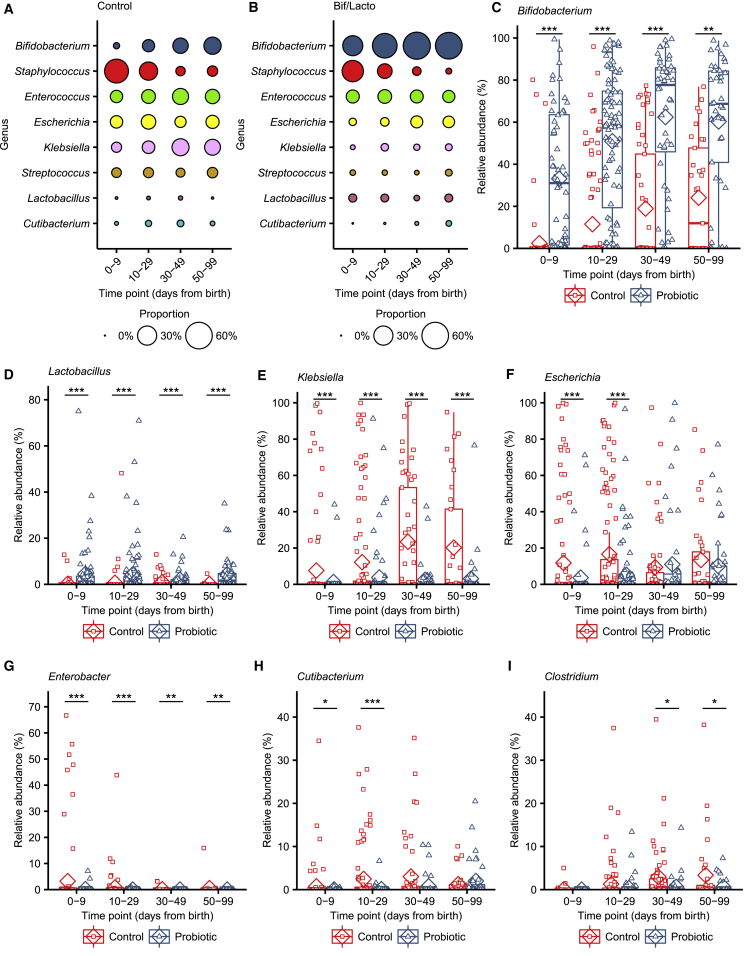
Genus Abundance between Bif/Lacto and Control Groups(A) Bubble plots show the mean group abundance of the common bacterial genera at each time point in the control group and the Bif/Lacto group.(C) Relative abundance of Bifidobacterium.(D) Relative abundance of Lactobacillus.(E) Relative abundance of Klebsiella,(F) Relative abundance of Escherichia.(G) Relative abundance of Enterobacter(H) Relative abundance of Cutibacterium(I) Relative abundance of Clostridium.For all plots: 0–9 days (control: n = 110, Bif/Lacto: n = 64); 10–29 days (control: n = 109, Bif/Lacto: n = 100); 30–49 days (control: n = 57, Bif/Lacto: n = 48); 50–99 days (control: n = 33, Bif/Lacto: n = 41). Boxplots show group median and interquartile range, diamonds indicate the group mean, and individual points highlight individual infant samples. Asterisks represent p values: ∗p < 0.05, ∗∗p < 0.01 ∗∗∗p < 0.001. See also Figure S2 and Data S4–S6.